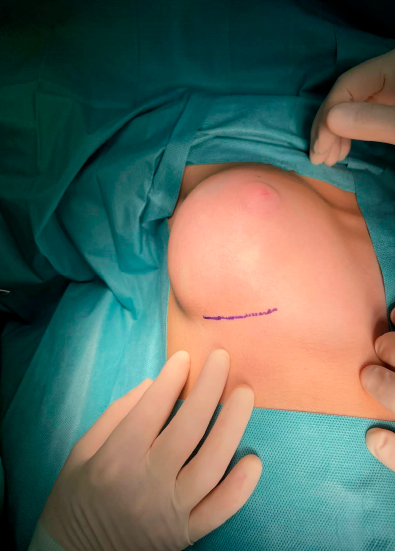
Figure 1. Macroscopic view of the right breast of the 11-year-old patient before surgery.